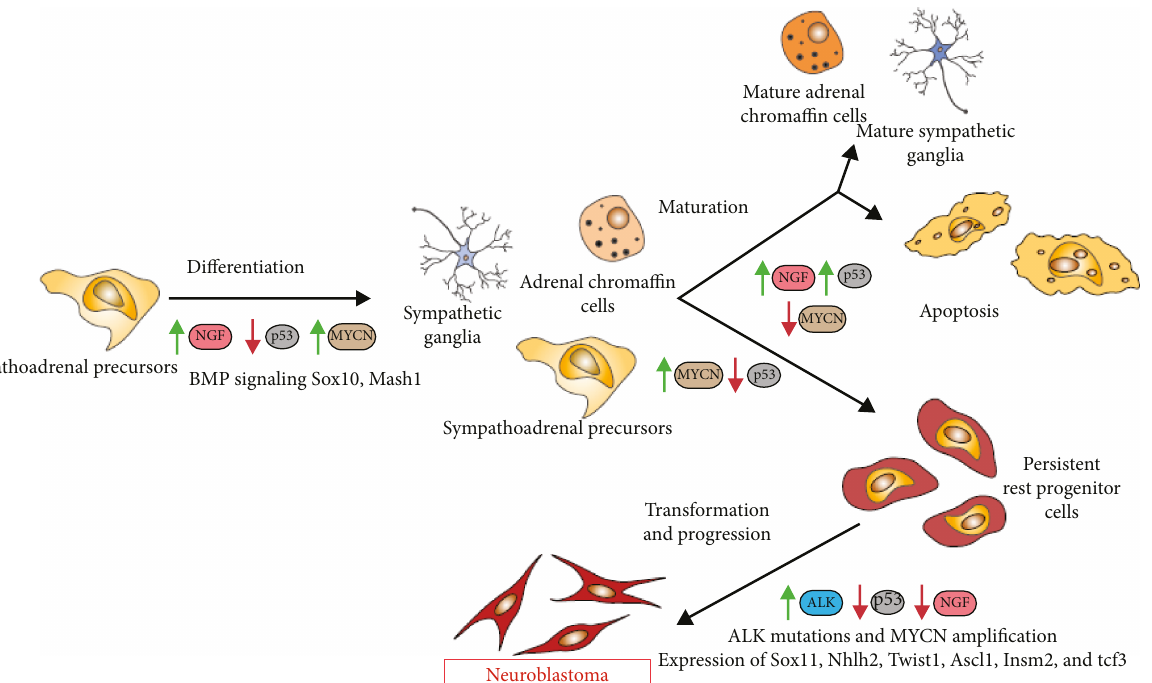
Figure 2: The transformation of neural crest cells into neuroblastoma